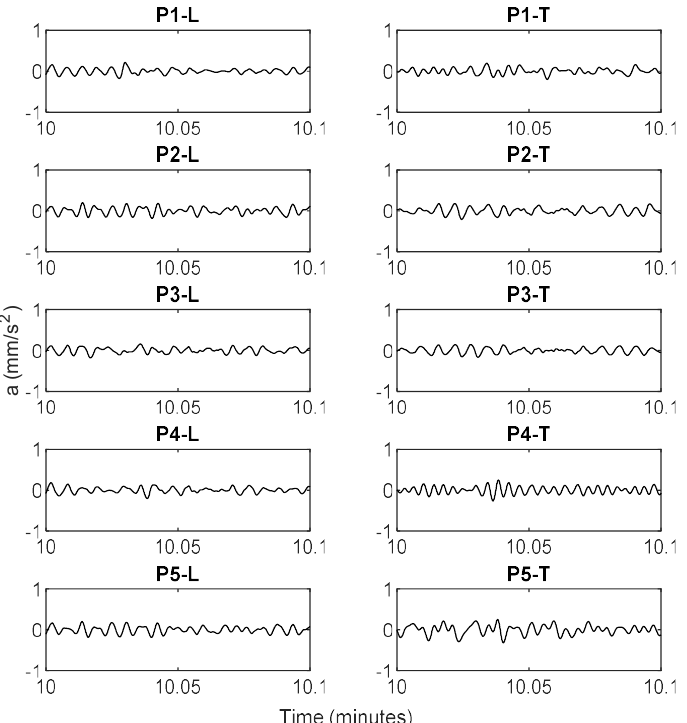
Figure 5. Six-second sections (from 10.0 to 10.1 min) of the processed acceleration–time histories. Natural Frequencies: The Accelerometric Technique